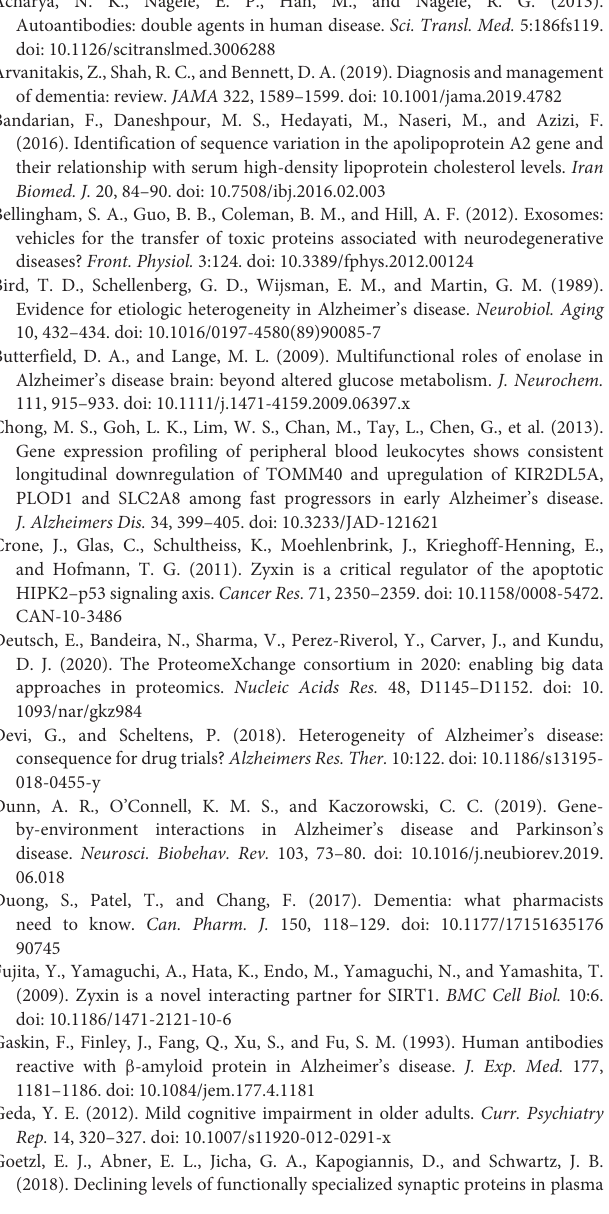
SUPPLEMENTARY TABLE 2 | Phenotypic information of all subjects used in proteomic analysis. SUPPLEMENTARY TABLE 3 | The results of fuzzy c-means clustering, including the assignments of exosomal proteins and the membership of exosomal